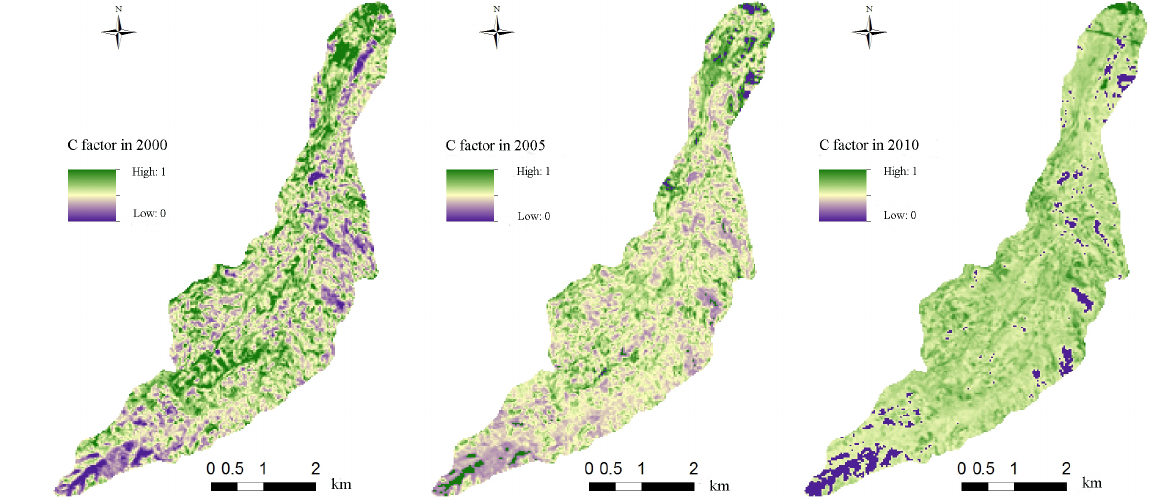
Figure 11. The spatial distribution of vegetation cover factor in the three study years.